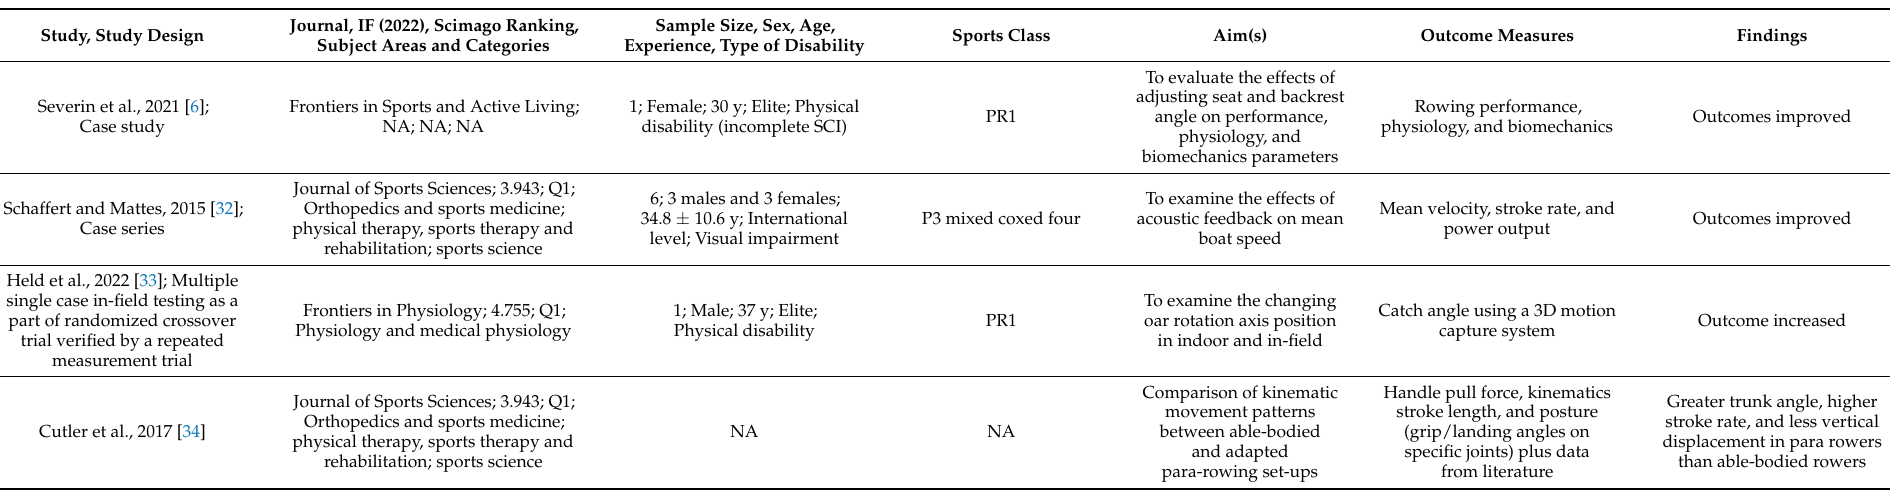
Table 3. Main characteristics of the study included in the present scoping review concerning the biomechanics of para-rowing. Abbreviations: IF (Impact Factor); NA (not available); SCI (spinal cord injury); y